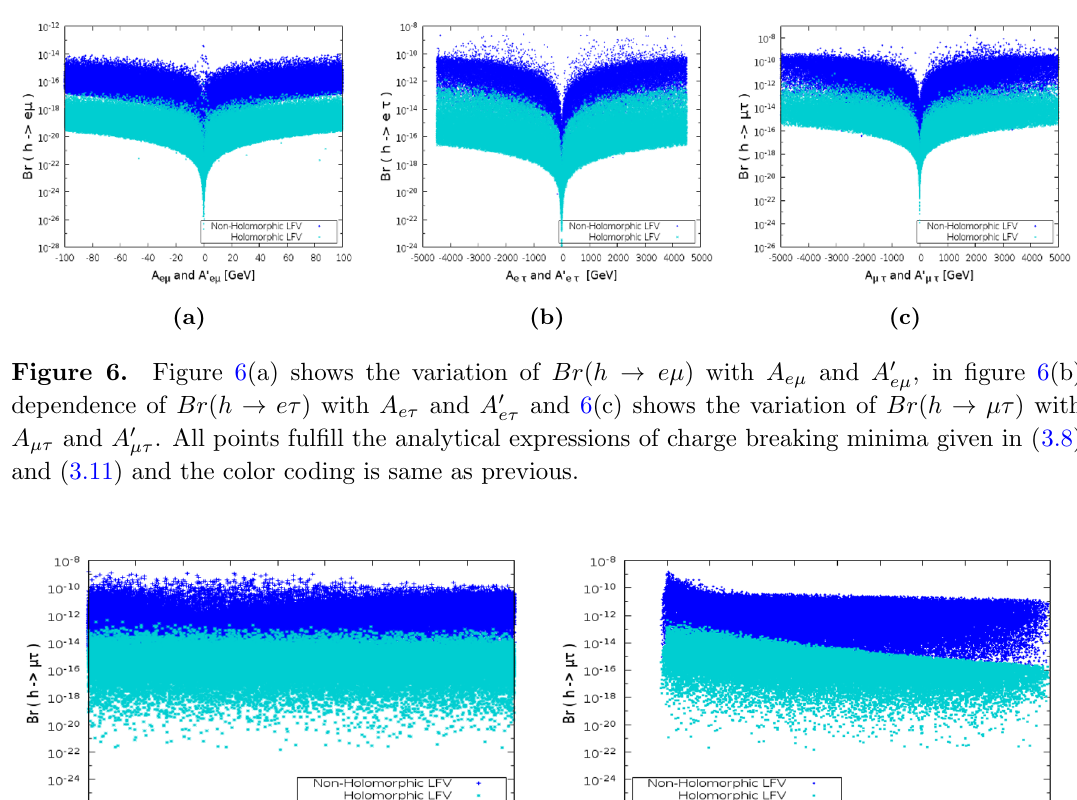
(cid:22)(cid:28) ) on M 1 . In the !